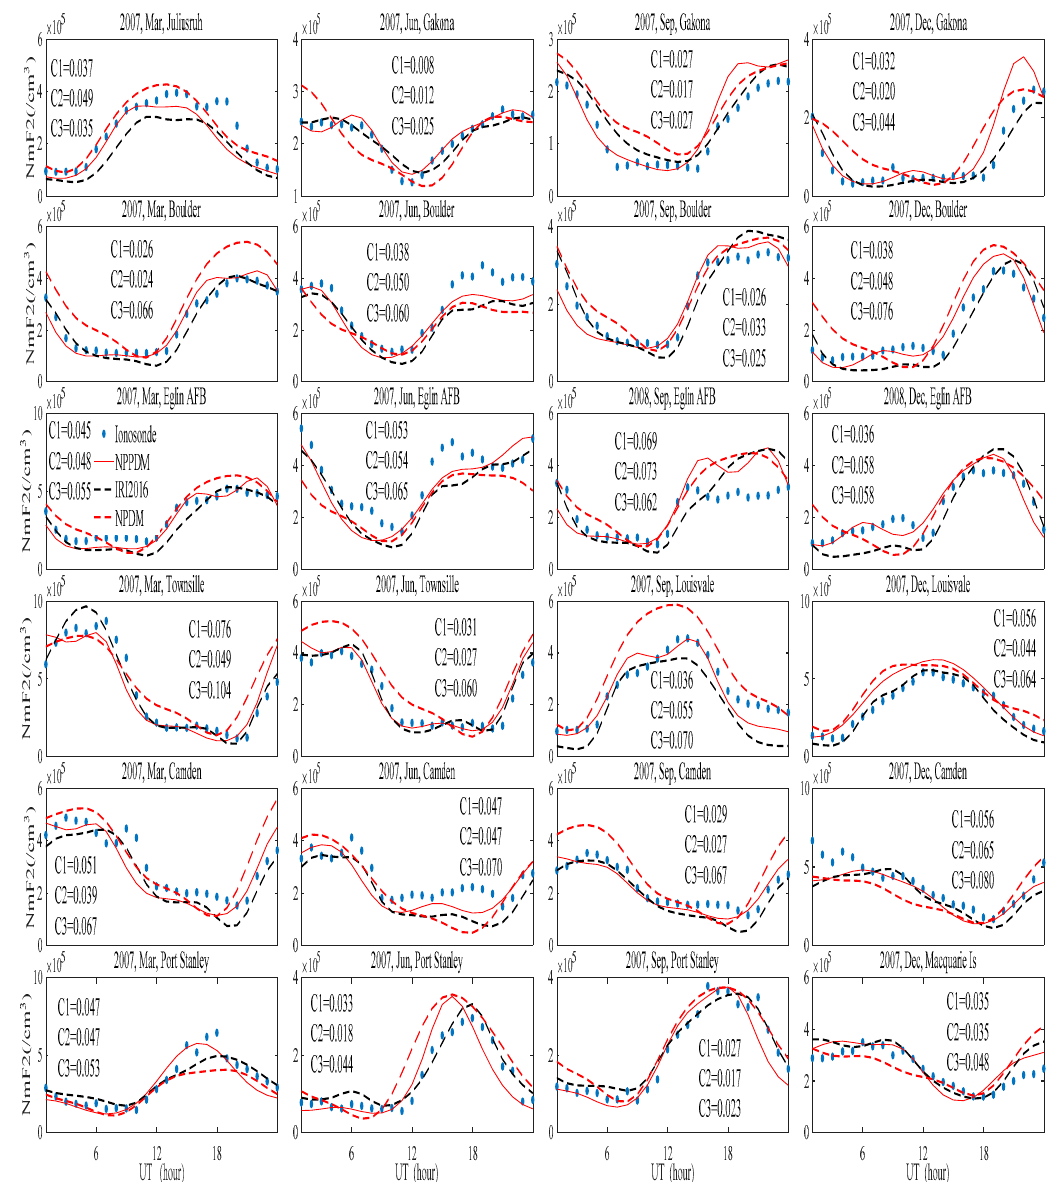
Figure 7. Variations of hourly mean of NPPDM (red solid lines), IRI2016 (black dotted lines) and NPDM (red dotted lines) as a function of UT in comparisons with ionosonde observation (dots) under low solar activity. C1, C2, and C3 are the analog deviations between NPPDM, IRI2016, and NPDM and ionosonde observations, respectively.